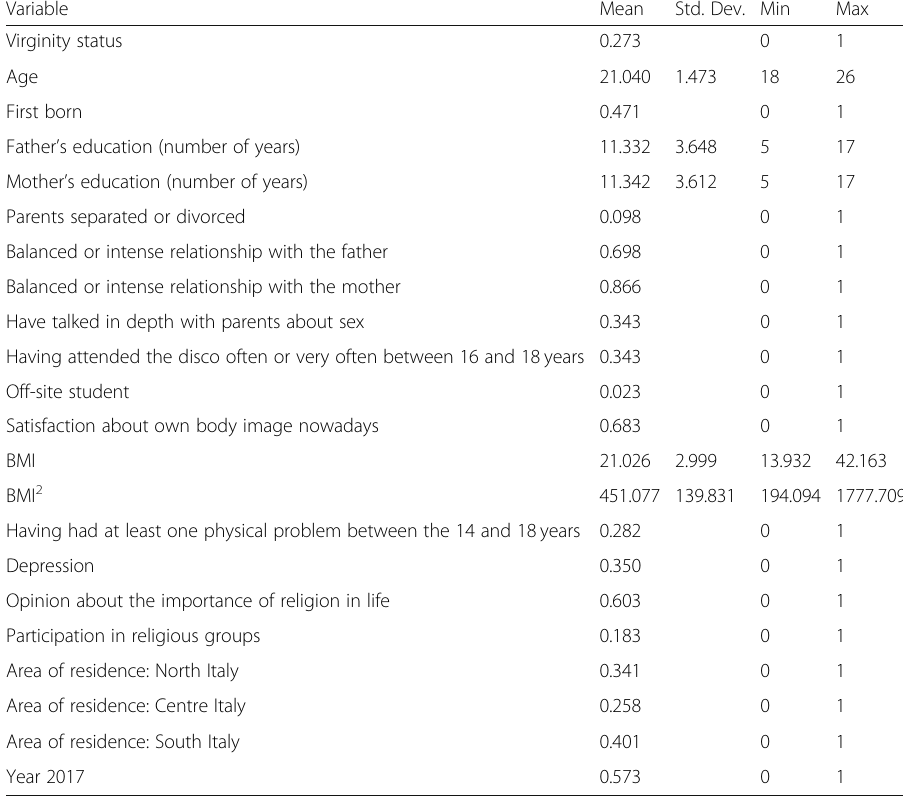
Table 5 Descriptive statistics of the complete sample (2000 and 2017). Females ( n =